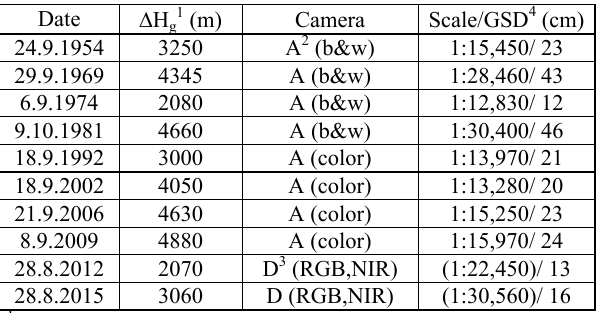
Table 1. Metric aerial surveys 1954-2015